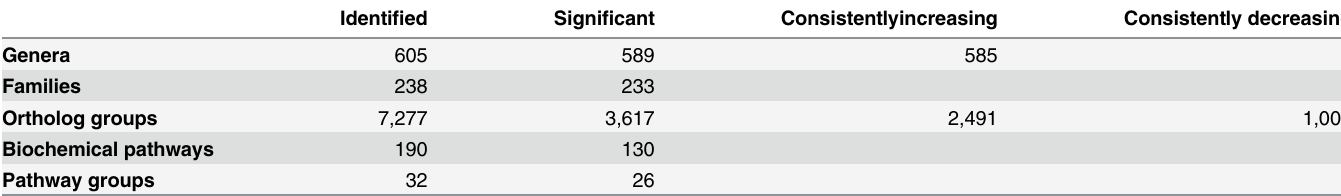
Table 1. Summary of statistically significant time effects on taxonomy and functional potential of the feline faecal